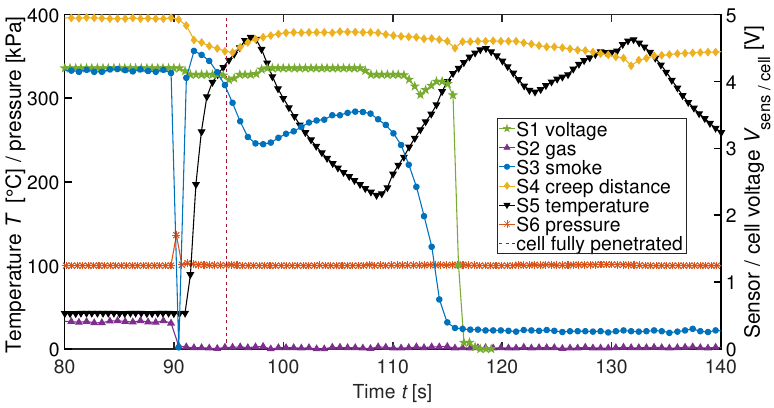
Figure 4. Measurements of test V3. The dashed line again displays when the trigger cell is completely penetrated. The detection window is about t detecWin ≈ 26s wide and therefore in the same range as in tests V1 and